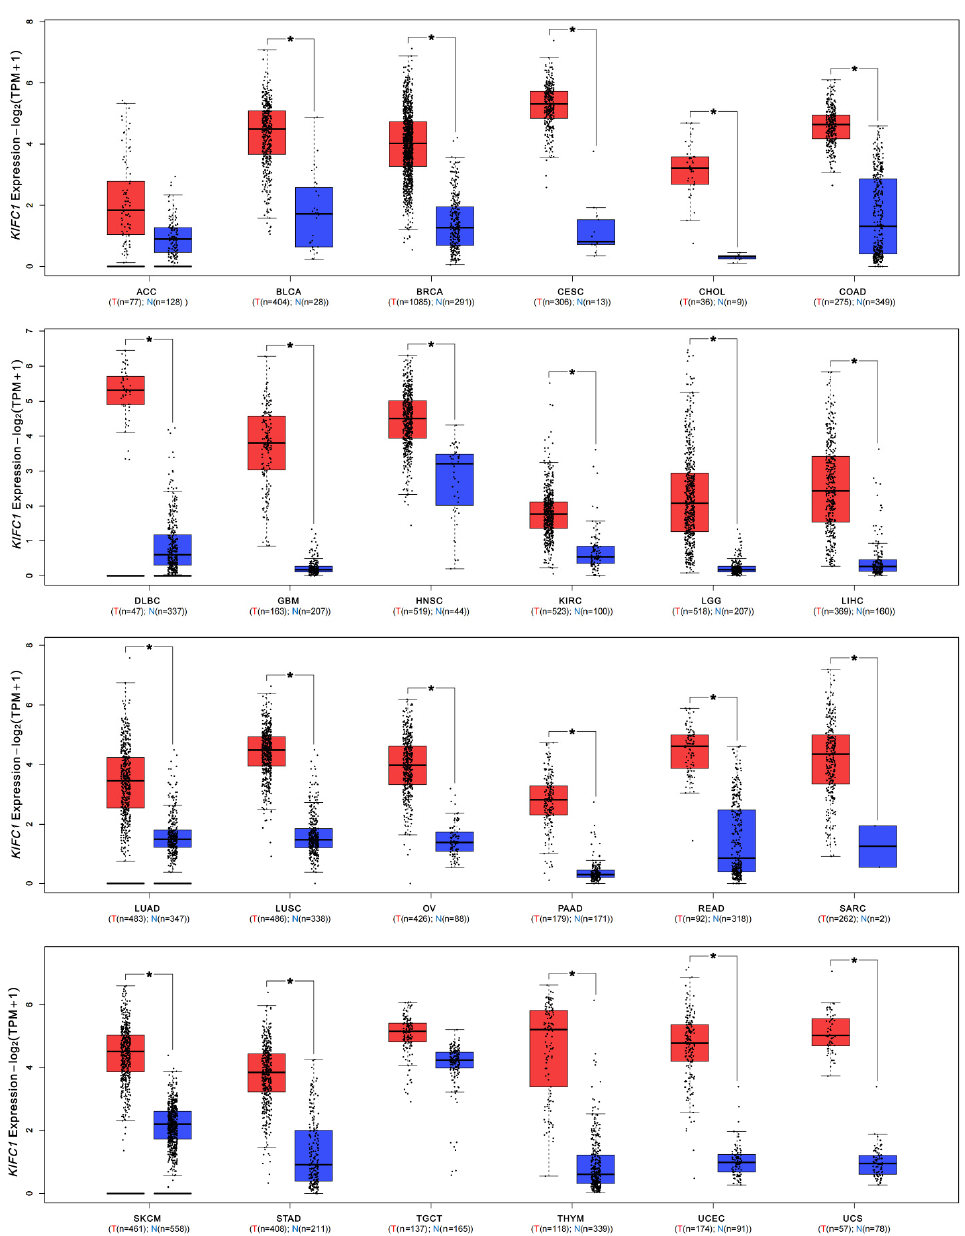
Figure 2. mRNA expression levels of KIFC1 in different tumors. The KIFC1 expression levels of different cancers in the TCGA database compared with normal tissues in GTEx database; Log 2 (TPM + 1) transformed the expression data for plotting. * p < 0.05, in Wilcoxon test. TPM: transcripts per million; N and T: normal and tumor tissues.